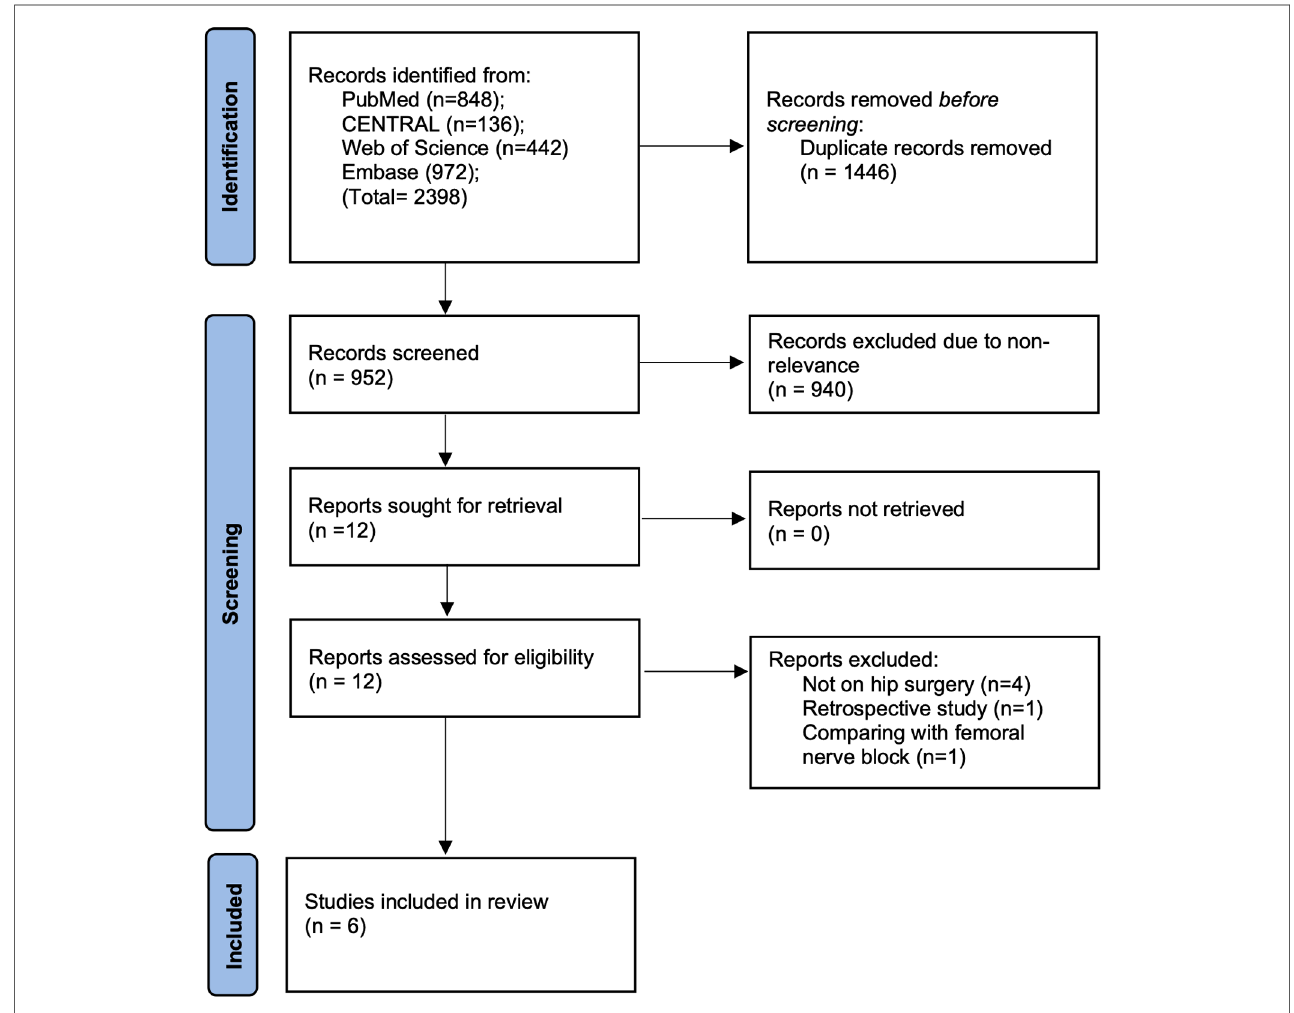
FIGURE 1 Study fl ow